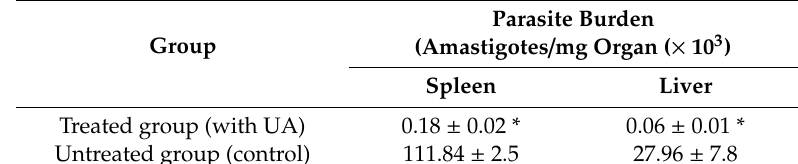
Table 3. In vivo antileishmanial e ffi cacy of UA against L. infantum in an acute infection model of visceral leishmaniasis (VL) in BALB / c. Parasite burden of the control (untreated) group and treated group with UA parenterally administered at 5 mg / kg daily for seven consecutive days. Results are expressed as mean parasite number ± standard deviation in spleen and liver per milligram. Group